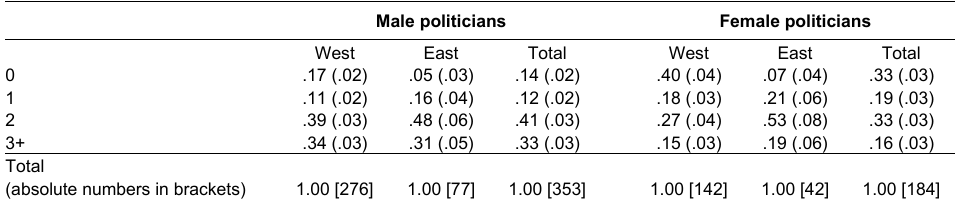
Table 2 : Distribution of politicians by number of children, gender, and region. Column fractions displayed, standard errors in parentheses.